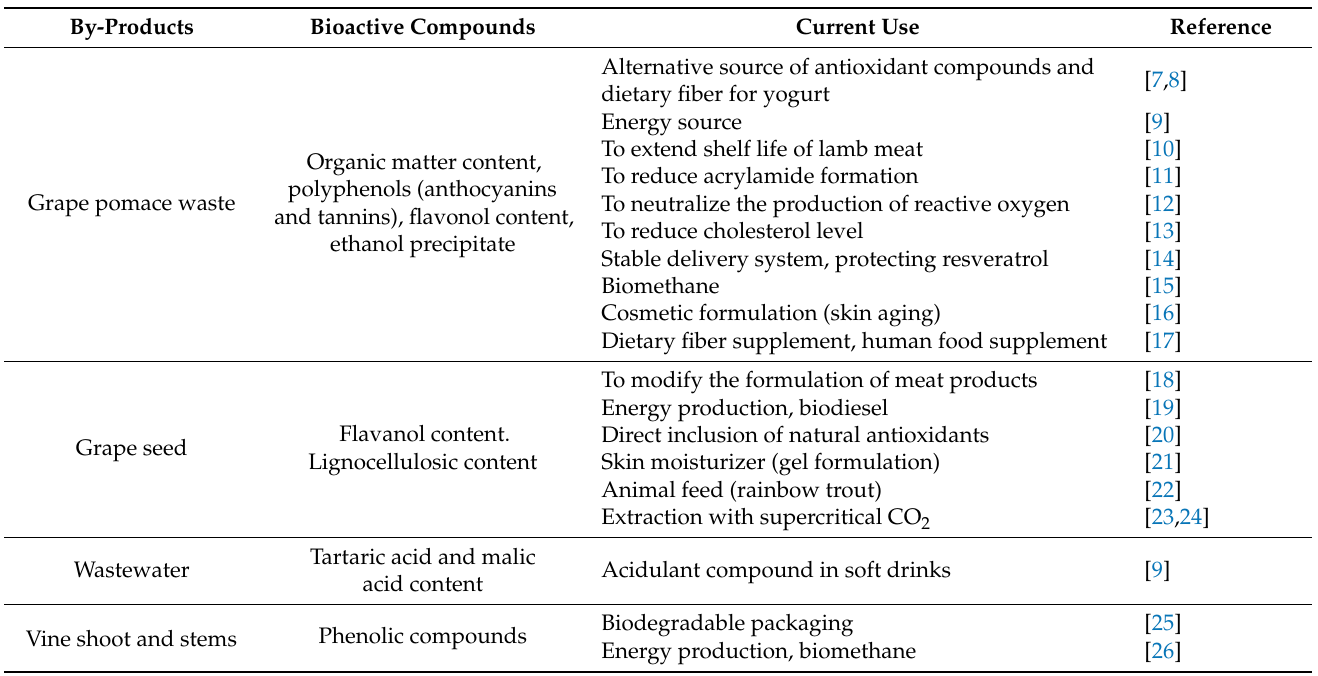
Table 1. Main by-products available in wine making and their